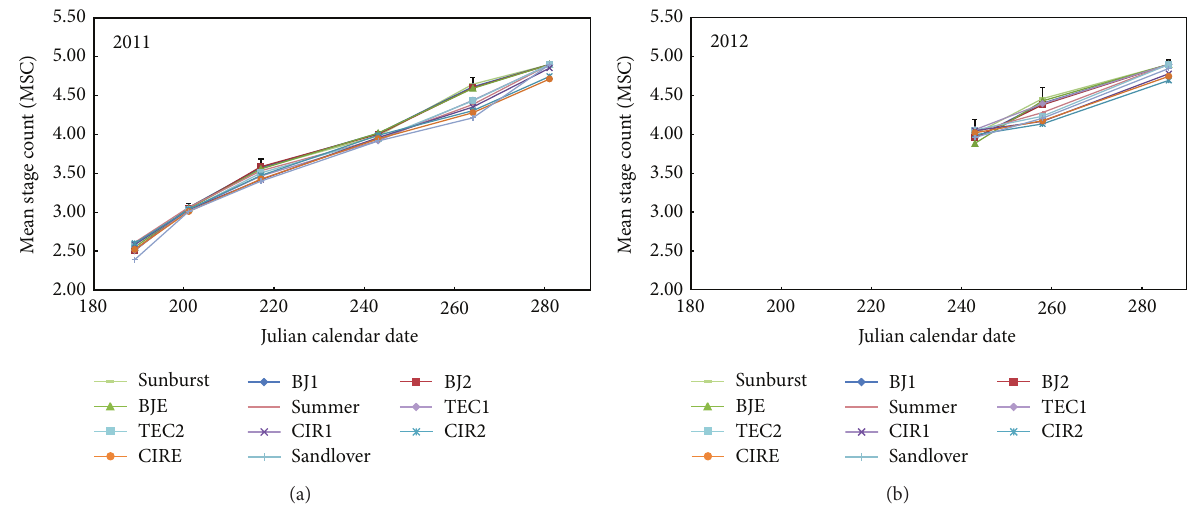
Figure 6: Mean stage count of 11 selections of switchgrass at Cookshire-Eaton, Quebec, in 2011 and 2012. Vertical bars represent the least significant difference (LSD, 𝑃 = 0.05 ) at each sampling point throughout the season. BJ1, Blue Jacket; BJ2, Blue Jacket II; BJE, Blue Jacket Early; TEC1, Tecumseh; TEC2, Tecumseh II; CIR, Cave-in-Rock; CIR2, Cave-in-Rock II; CIRE, Cave-in-Rock